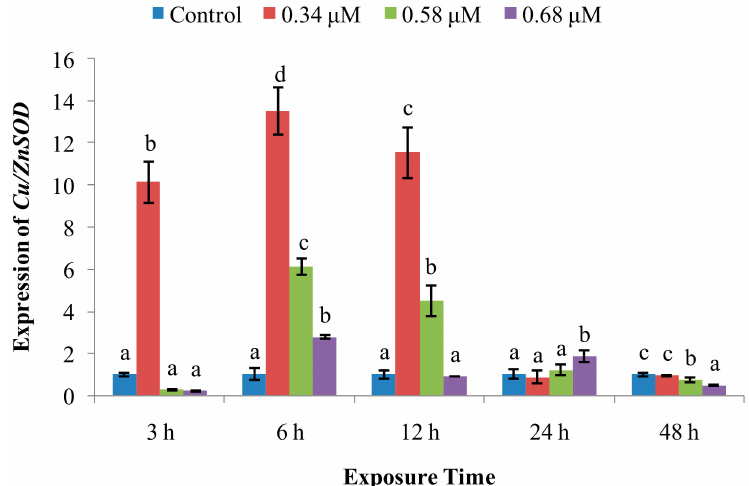
Figure 6. E ff ect of TD 49 on hemolymph Cu / ZnSOD expression at di ff erent time points after exposure to di ff erent concentrations (0, 0.34, 0.58, 0.68 µ M) of TD 49 . Data represent mean ± SD values ( n = 3) at the same time interval, with di ff erent letters denoting significant di ff erences ( p < 0.05).